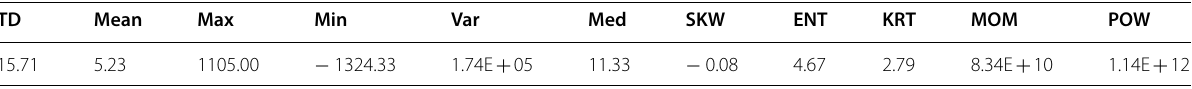
Table 3 Averaged extracted features of the three selected